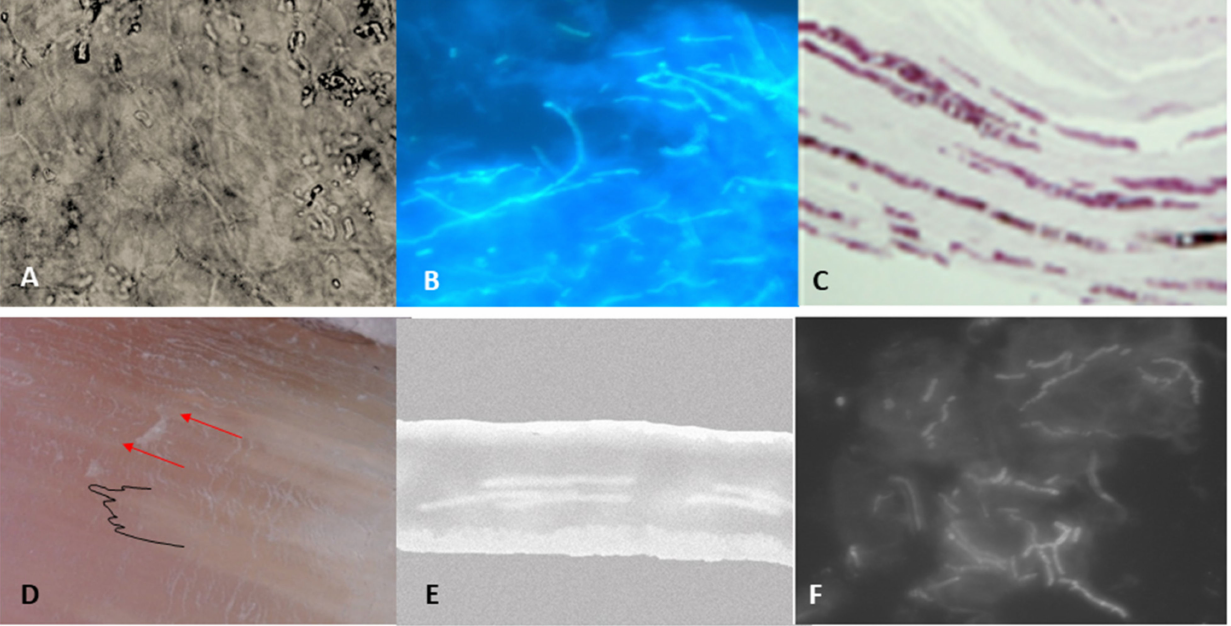
Figure 1. Examples of outputs produced for visual methods of identification . ( A ) Standard KOH exam photo showing hyphae; ( B ) KOH exam of hyphae using fluorescent microscopy; ( C ) Septate black hyphae in the nail plate (periodic acid-Schiff staining × 400) from Figure 2b in [7]; ( D ) Illus- tration of dermoscopy onychomycosis signs in the nail plate: jagged proximal edge (black outline), longitudinal striae (red arrows); ( E ) Optical coherence tomography: digital illustration of output through nail plate showing hyphae; ( F ) Confocal microscopy: illustration of visualized